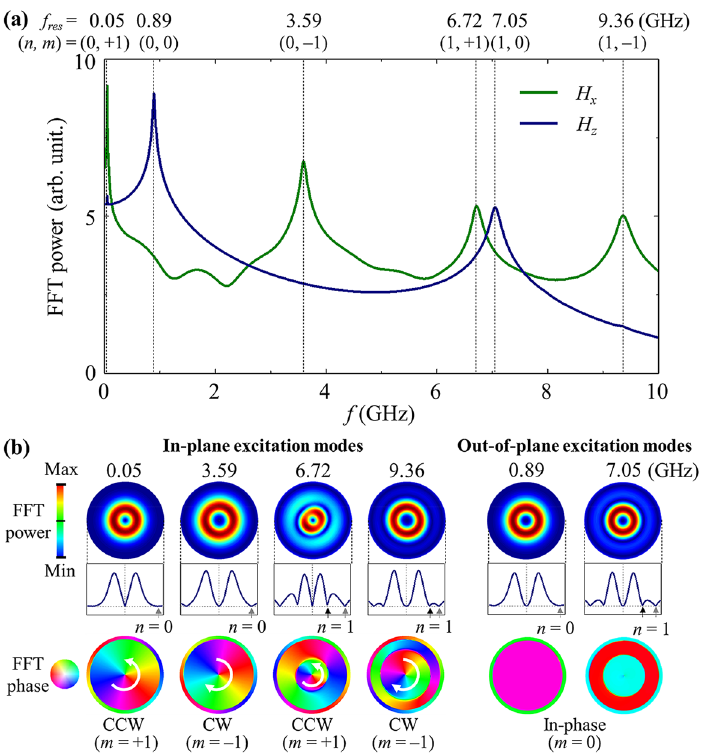
Figure 4. Excited dynamic modes in skyrmion state. ( a ) FFT-power spectra averaged over entire area of hemispherical shell for 2 R = 100 nm and K u = 0.25 MJ/m 3 , as obtained from FFTs of temporal oscillations of m r at all individual nodes, which are excited by each of two different field directions, H x (green line), and H z (navy line). ( b ) Unrolled-view images of spatial distributions of FFT powers along with corresponding line profiles across center position (top) and FFT phase (bottom) for in-plane excitation (0.05, 3.59, 6.72, and 9.36 GHz) and out-of-plane excitation (0.89 and 7.05 GHz)